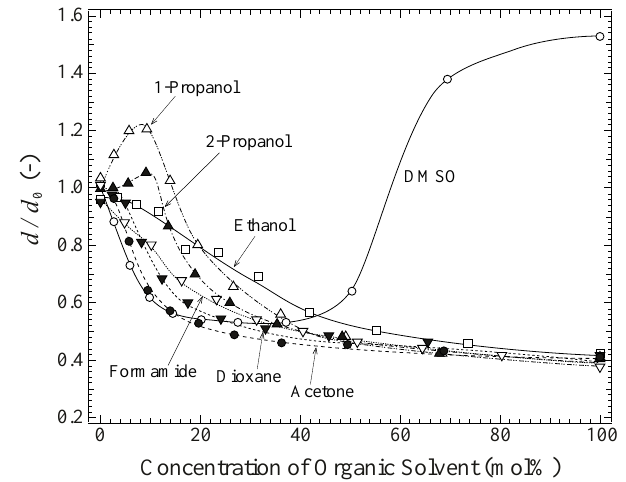
Figure 1. Swelling ratio of chemically crosslinked and dehydrated gels with different ratios of aqueous/organic solvent mixtures at room temperature (25 °C) measured by a multiple-sample test.